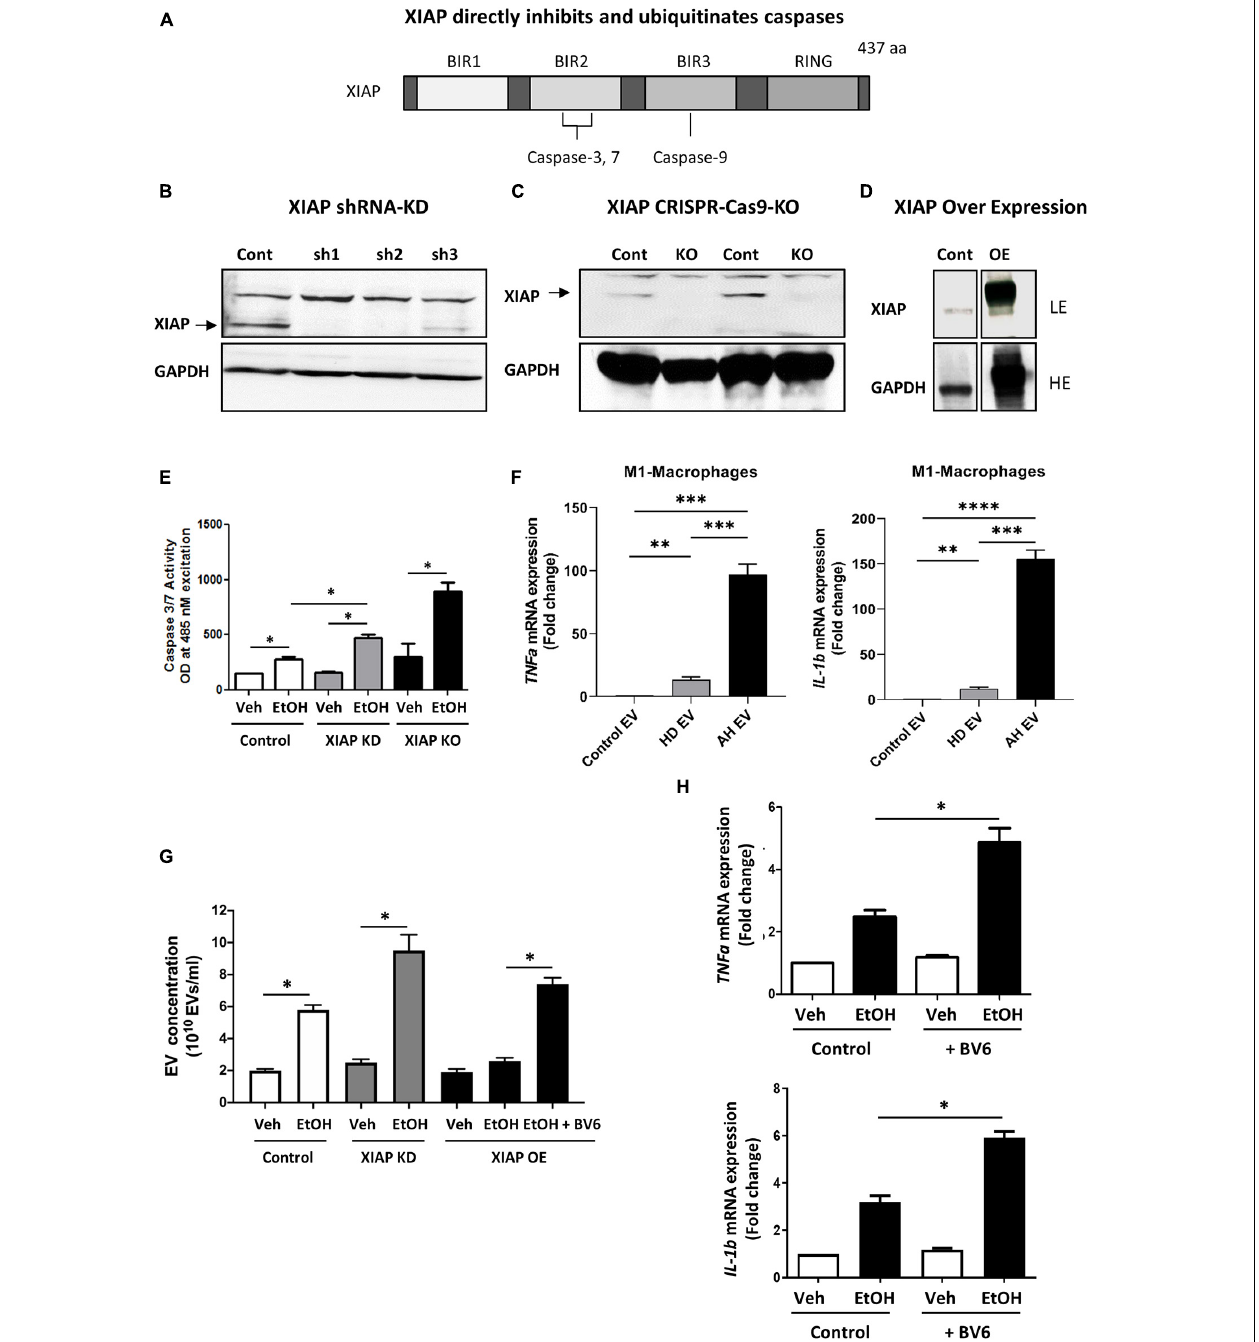
FIGURE 1 | XIAP knockdown potentiates ethanol-induced apoptosis and inflammation in HepG2 Cyp 2 e 1 cells. (A) Scheme shows XIAP gene structure containing caspase-binding sites. (B) Protein levels of XIAP determined by Western blot in HepG2 Cyp 2 e 1 transfected with non-targeted shRNA (Cont) or shXIAP (sh). (C) Protein levels of XIAP determined by Western blot in control HepG2 Cyp 2 e 1 (Cont) and XIAP CRISPR-Cas9-KO HepG2 Cyp 2 e 1 (KO). (D) Protein levels of XIAP determined by Western blot in HepG2 Cyp 2 e 1 transfected with empty vector (Cont) or with XIAP plasmid (overexpression, OE) (LE, low exposure; HE, high exposure). (B–D) GAPDH protein levels were used as a loading control for total protein. (E) Evaluation of Caspase 3/7 activity in control HepG2 Cyp 2 e 1 (Control), HepG2 Cyp 2 e 1 transfected with shXIAP (XIAP KD), and in XIAP CRISPR-Cas9-KO HepG2 Cyp 2 e 1 (XIAP KO) treated with vehicle (Veh) or with 50 mM ethanol (EtOH). (F) Effect of EVs isolated from AH patients in mRNA expression of TNFa (left panel) and IL-1b (right panel) in M1 macrophages determined by qRT-PCR. (G) EV release counting in control HepG2 Cyp 2 e 1 (Control), HepG2 Cyp 2 e 1 transfected with shXIAP (XIAP KD), and in XIAP-vector-transfected HepG2 Cyp 2 e 1 (XIAP OE) treated with vehicle (Veh) or with 50 mM ethanol (EtOH). (H) Relative mRNA levels of TNFa (left panel) and IL-1b (right panel) determined by qRT-PCR and expressed as fold change. GAPDH was used as a housekeeping gene ( ∗ p < 0.05; ∗∗ p < 0.01; ∗∗∗ p < 0.005; and ∗∗∗∗ p < 0.001, n = 3).